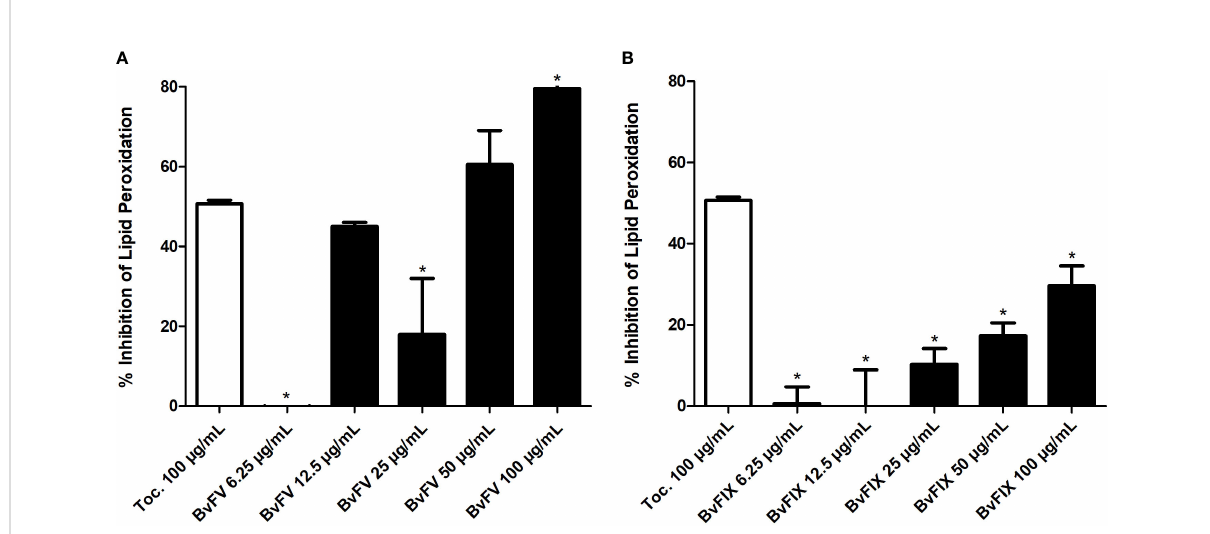
FIGURE 4 Assessment of lipid peroxidation. The linoleic acid method was used to evaluate the inhibition of lipid peroxidation. The results presented represent mean ± S.E.M. in the percentage of lipid peroxidation inhibition. (A) BvFV and (B) BvFIX. The statistical test applied was the analysis of variance (one-way ANOVA) followed by Dunnett ’ s test. *, p < 0.05 vs. tocopherol at 100 m